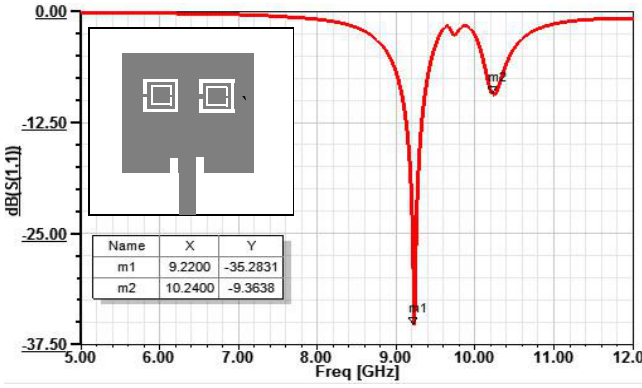
Figure 6: Dual-band antenna with two CSRR